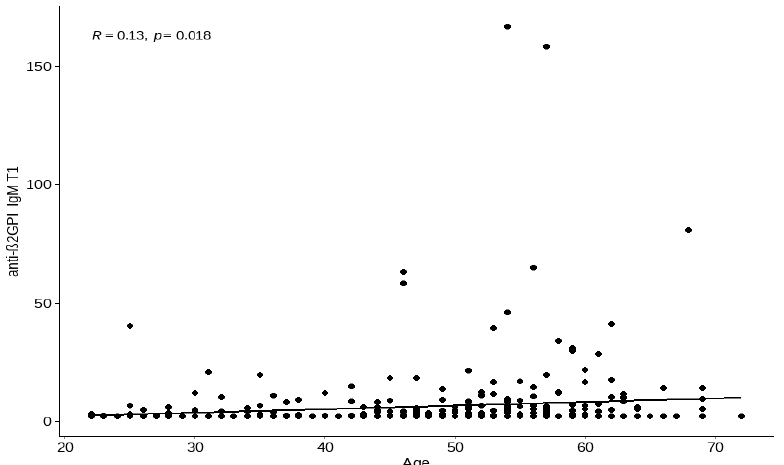
Figure 1. The quantitative analysis of the relationship between anti- β 2-glycoprotein I antibodies (anti- β 2GPI IgM T1) and the age of subjects before the third vaccine dose. The strength of these correlations is weak (R = 0.13). Abbreviations: T1-laboratory assay before the third dose (median number of days: 230).